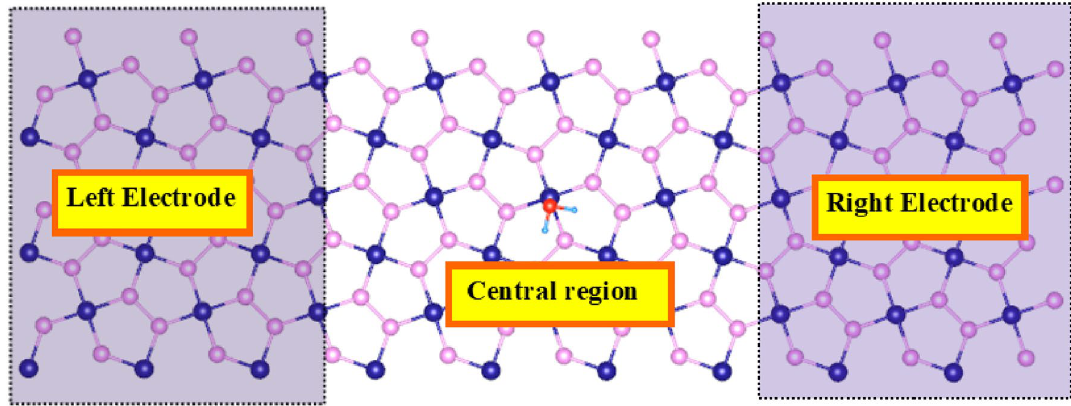
Figure 5. Schematic structural model of a gas sensor based on penta-PdAs 2 + H 2 S with two electrodes. The Pd, As, H and S atoms are indicated in navy blue, pink, water blue and red colors, respectively.